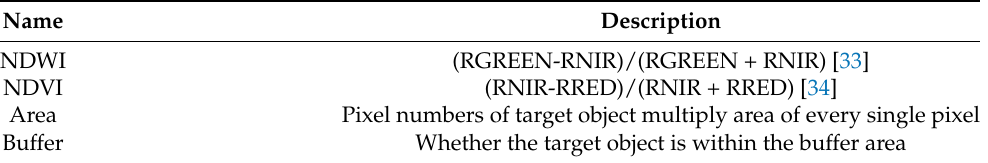
Table 1. Summary of the features explored in this study and their